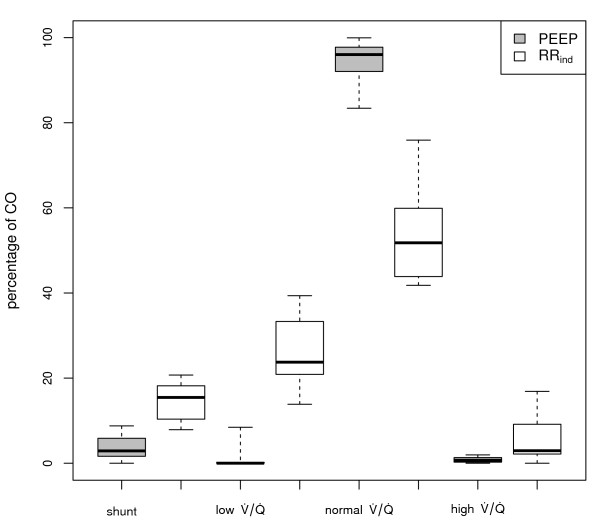
Ventilation/Perfusion distribution after PEEP or RRind intervention. MMIMS-MIGET derived V⋅/Q⋅ after 30 minutes of intervention: maintained lung recruitment in the PEEP group and impaired pulmonary function in the RRind group. Intergroup differences: shunt, low and normal V⋅/Q⋅ each P ≤ 0.001, high V⋅/Q⋅P = 0.012 (Mann-Whitney-U-Tests).